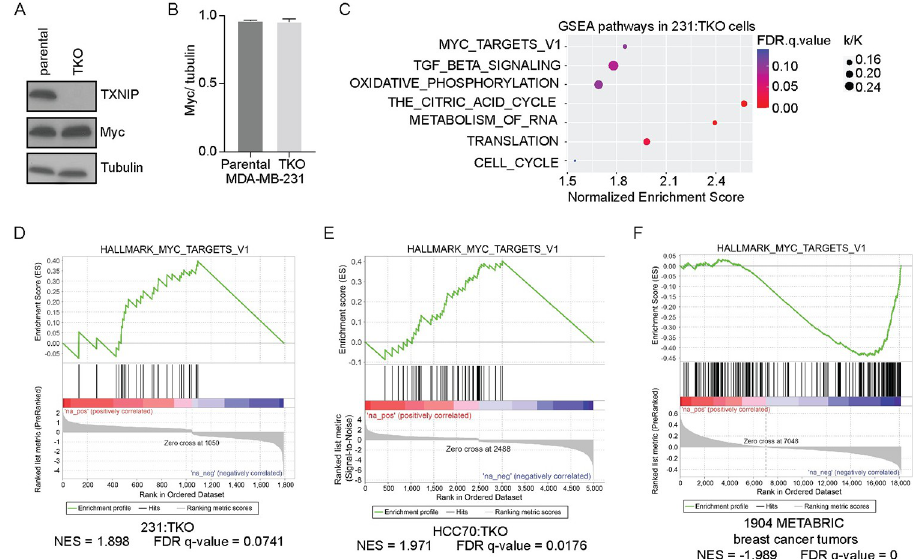
Fig 1. TXNIP loss mimics Myc overexpression. ( A ) Western blotting was used to determine the levels of the Myc, TXNIP, and tubulin in MDA-MB-231 (parental 231) and 231:TKO cells. ( B ) Quantification of Myc protein levels (normalized to those of tubulin) from ( A ) in parental 231 and TKO cells using ImageJ. The image of the western blot used for quantification is shown in S1C Fig. ( C ) RNA sequencing was performed on 2 biological replicates of each parental 231 and 231:TKO cells to identify TXNIP-regulated genes. Preranked GSEA was performed by comparing up- and down-regulated genes in 231:TKO cells with the Hallmark and Reactome datasets in the MSigDB. The enriched GSEA pathways of TXNIP-regulated genes were plotted using ggplot2 package from R studio. The k/K value is a ratio of number of genes in our data set (k) divided by the number of genes in the indicated dataset (K). ( D ) The preranked GSEA plot of enrichment of the regulated genes in 231:TKO cells with the Hallmark_Myc_targets_v1 dataset. Because the FDR q-value accounts for multiple hypothesis testing and the small size of the datasets being queried, FDR q-values of up to 0.25 are suitable for hypothesis generation [31,32].( E ) The preranked GSEA of regulated genes in HCC70: TKO (HCC:TKO) cells with the Hallmark_Myc_targets_v1 dataset. ( F ) A rank ordered gene list was developed by correlating TXNIP expression with the expression levels of all transcripts expressed in the 1,904 breast cancer tumors available in the METABRIC dataset [34]. This preranked gene list was used in a GSEA of the Hallmark datasets from the MSigDB. An enrichment plot for Hallmark_Myc_targets_v1 is shown. The underlying data for Fig 1B and 1C can be found in S1 Data. GSEA AU : AbbreviationlistshavebeencompiledforthoseusedinFigs 1 (cid:0) 7 : Pleaseverifythatallentriesarecorrect : , Gene Set Enrichment Analysis; METABRIC, Molecular Taxonomy of Breast Cancer International Consortium; MSigDB, Molecular Signatures Database; TKO, TXNIP-knockout; TXNIP, thioredoxin interacting